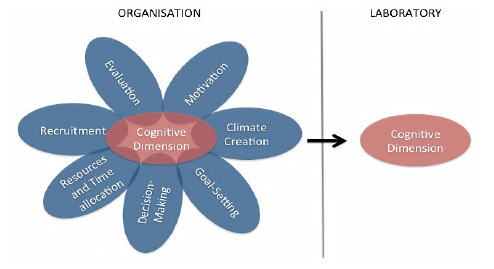
Fig. 2. Variables: organization versus laboratory